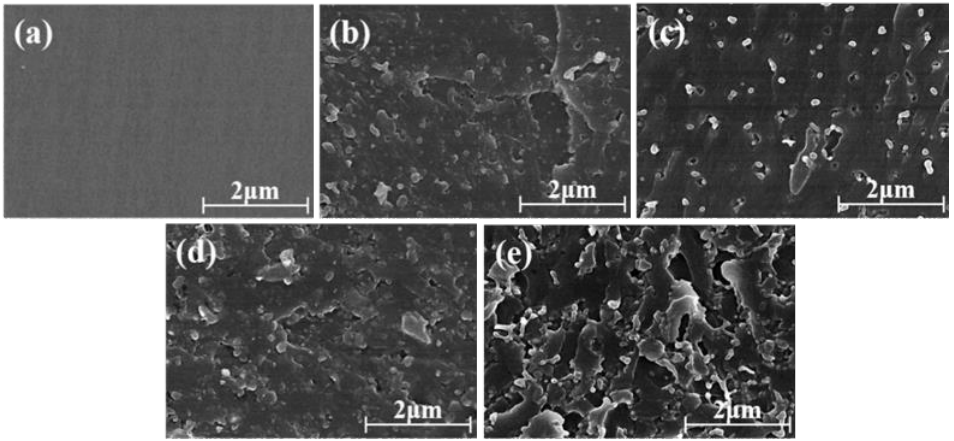
Figure 10. Scanning electron microscope (SEM) images of the fractured surfaces of the PSF/epoxy blends: ( a ) 0 phr, ( b ) 5 phr, ( c ) 10 phr, ( d )15 phr and ( e ) 20 phr.